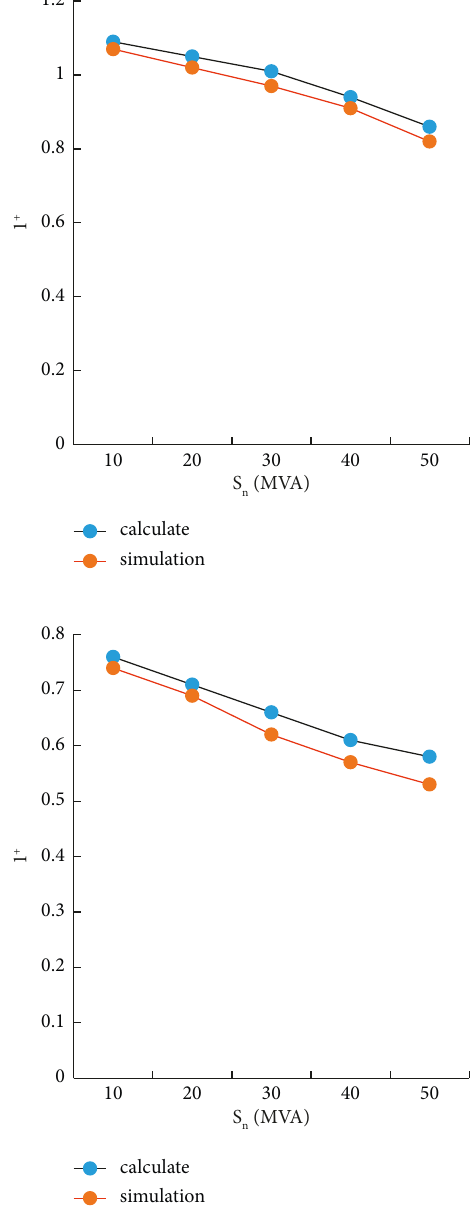
Figure 10: Converter short-circuit current for different short-circuit types and control